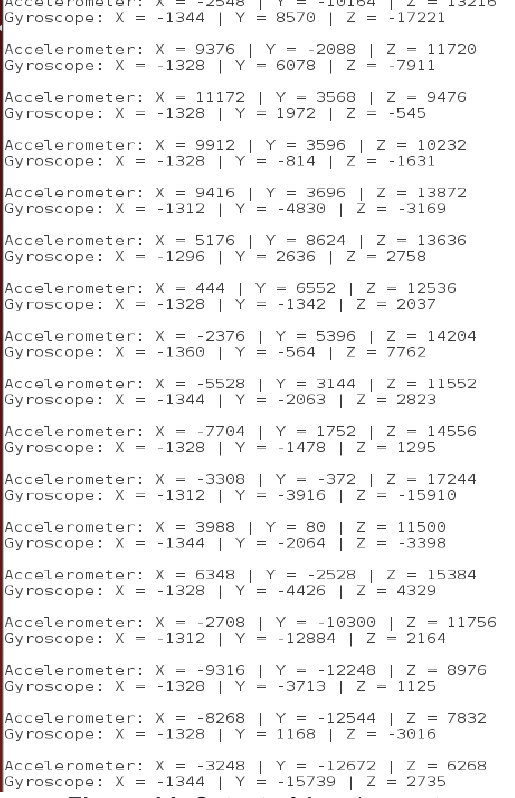
Figure 14. Output of Accelerometer